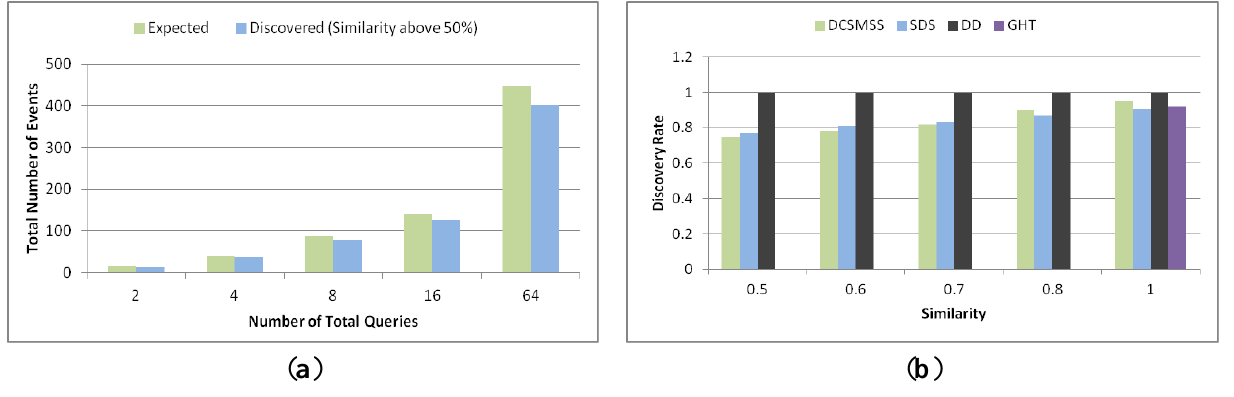
Figure 16. ( a ) Total number of events and ( b ) discovery